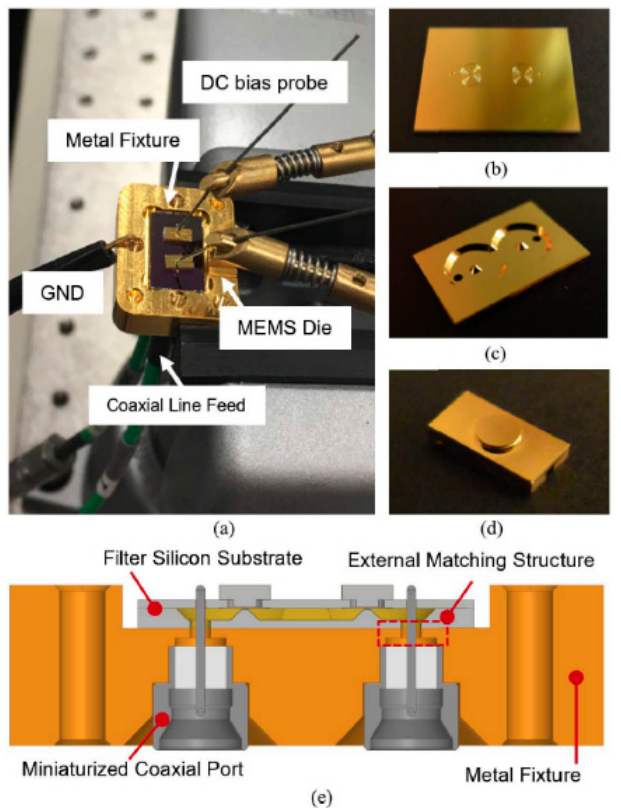
Figure 2. ( a ) RF system installation of the two BPF reconfigurable filters; ( b ) The front side of the diaphragm; ( c ) The front side of the cavity; ( d ) Side view of the DC bias circuit; ( e ) A cross-sectional view of the installed package system [39].